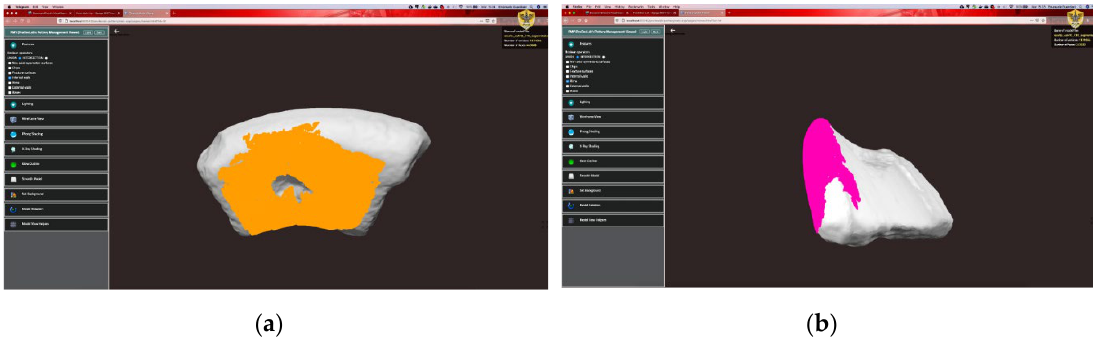
Figure 6. Web interface of object viewer. ( a ) The internal wall has been selected as displayed feature. ( b ) The rim is displayed.